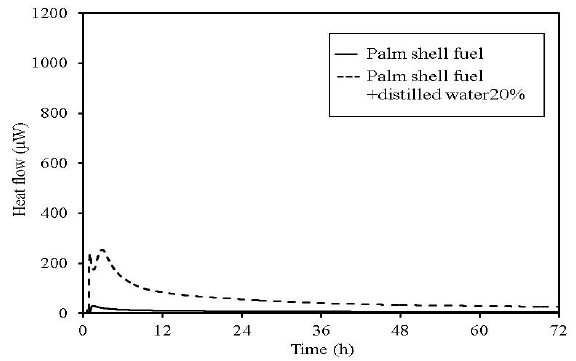
Figure 14. TAM calorimetry curves for palm shell